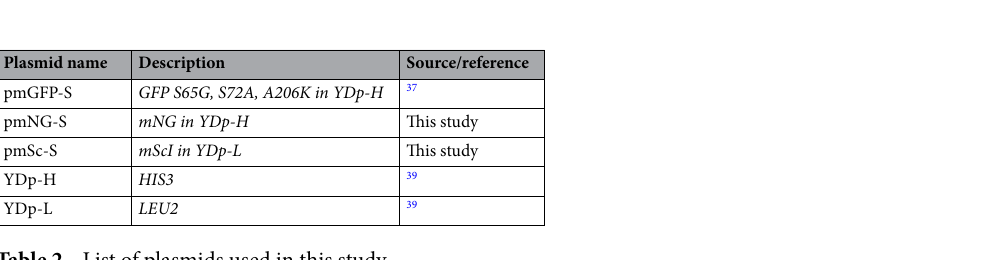
Table 2. List of plasmids used in this